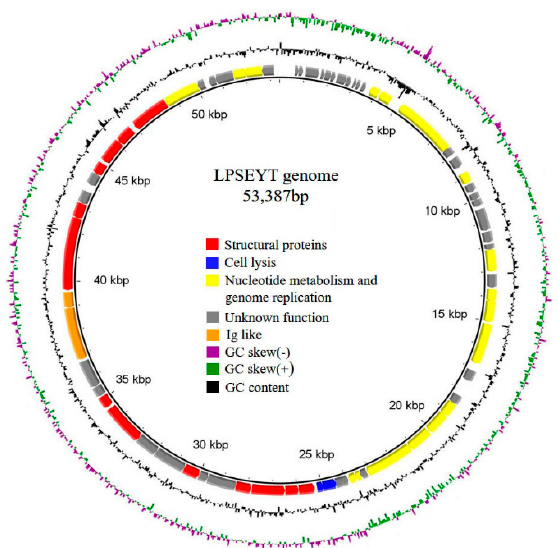
Figure 4. Genomic organization of LPSEYT. Patterns are divided into four circles: the full length of the genome is indicated in the first circle; the open reading frame is indicated in the second circle, and ORFs are transcribed in the clockwise or the counterclockwise direction; GC content is indicated in the third circle; while on the fourth circle, GC skew of G-C / G + C is indicated as green and purple, and green means that the value of GC skew is greater than 0 and purple means that the value is less than 0. The open reading frames marked with red, blue, yellow and orange indicate genes encoding structural proteins, cell lysis proteins, nucleotide metabolism and genome replication proteins, and Ig-like proteins, respectively; ORFs with homology to unannotated proteins or hypothetical proteins in the database are indicated in grey.